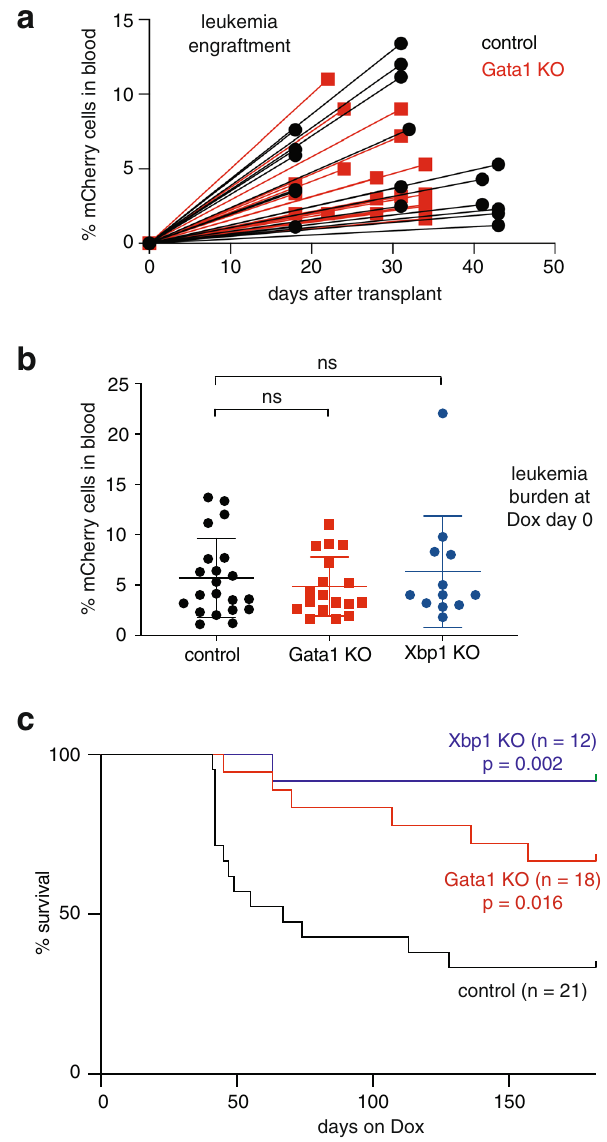
Fig. 7 Eosinophil lineage ablation can prevent AML relapse following differentiation therapy. a Blood leukemia burden indicating engraftment of control and Gata1 knockout AML246 clones in recipient mice following intravenous transplant of 1 million leukemia cells. b Proportion of mCherry + AML cells in the peripheral blood of mice transplanted with AML246- Cherry cells from control sgRNA clones (black), Gata1 knockout clones (red), or Xbp1 knockout clones (blue). Bleeds were taken at the time of established disease, when Dox treatment was initiated for the survival analysis shown in c . n = 21, 18, and 12 mice per group respectively over two independent experiments. Mean + / − SD. Relative to control, Gata1 KO p = 0.46 and Xbp1 KO p = 0.7, unpaired two-sided Student ’ s t -test. c Kaplan – Meier survival analysis of mice from b over 6 months of sustained Dox treatment. Relative to control, Gata1 KO p = 0.016 and Xbp1 KO p = 0.002, Mantel-Cox test. n = 21, 18, and 12 mice per group respectively. Source data are provided as a Source Data fi